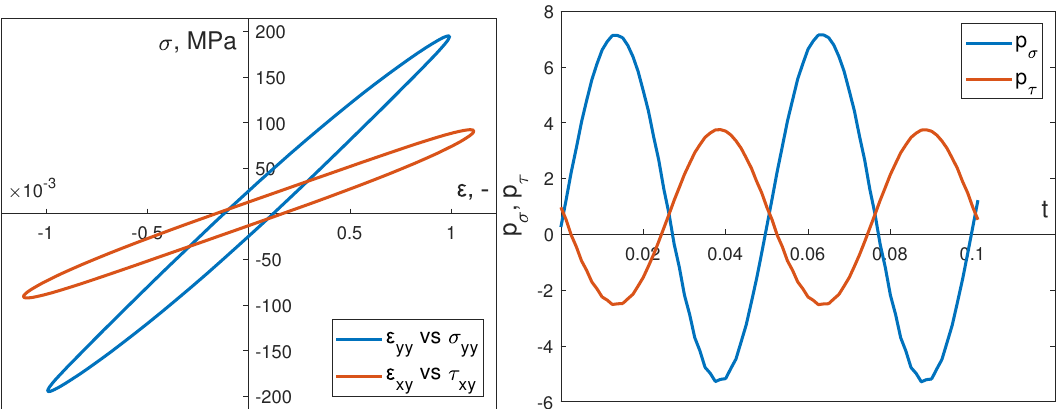
Figure 12. Stabilized calculated hysteresis loops for dynamic out-of-phase load and calculated instantaneous power (bending) p σ and torsion p τ .